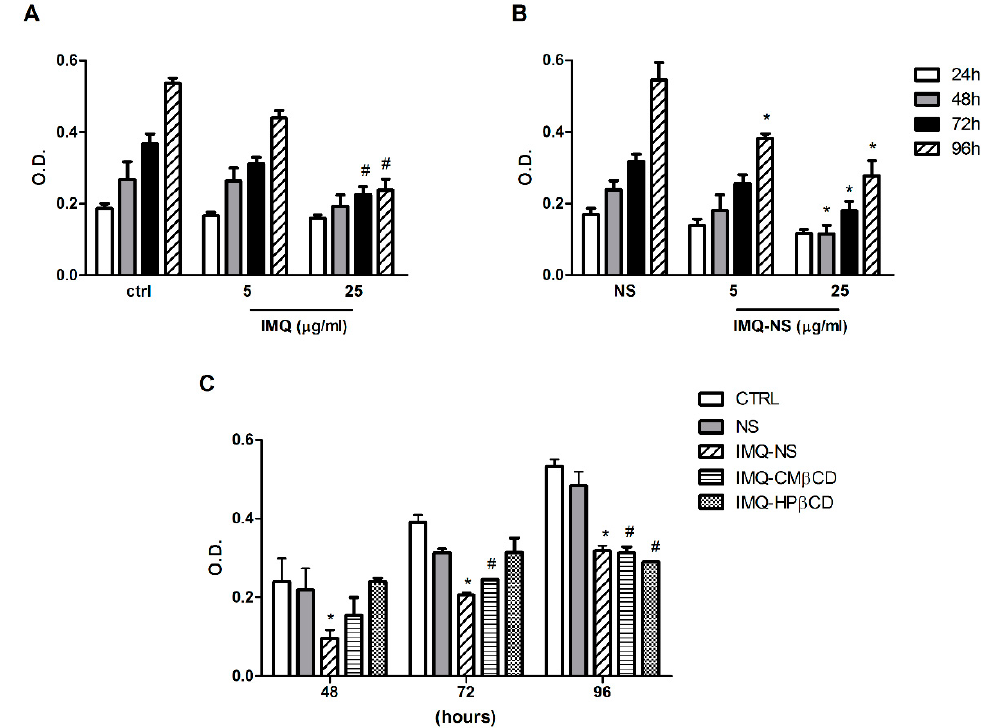
Figure 7. Effect of free IMQ, IMQ–NS and IMQ–CD complexes on the proliferation of normal skin-derived fibroblasts. Fibroblasts were left untreated or treated with 5 and 25 µ g/mL of free IMQ, blank NS (NS) and IMQ–NS ( A , B ) or with NS, IMQ–NS, IMQ–CM β CD and IMQ–HP β CD at 25 µ g/mL ( C ) for the indicated times. Data are shown as the optical density (O.D.). Cell proliferation is presented as mean ± SEM of three independent experiments. # p < 0.05 vs. untreated cells, * p < 0.05 vs. NS as appropriate, by two-way ANOVA followed by Bonferroni post